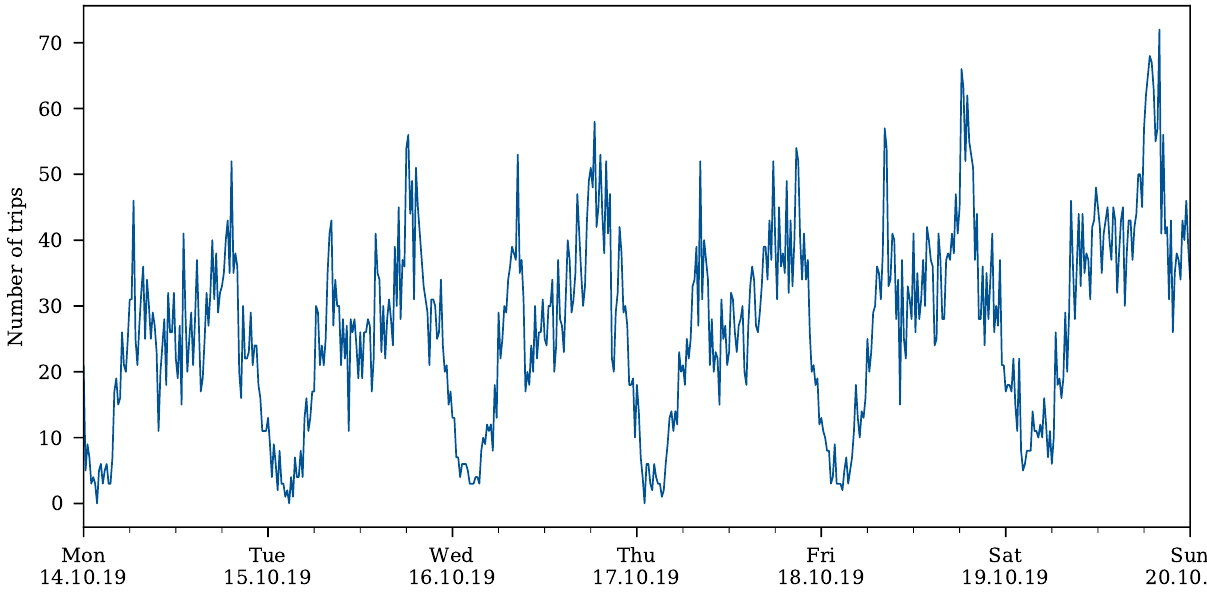
Figure 4. Number of Carsharing Trips during Example